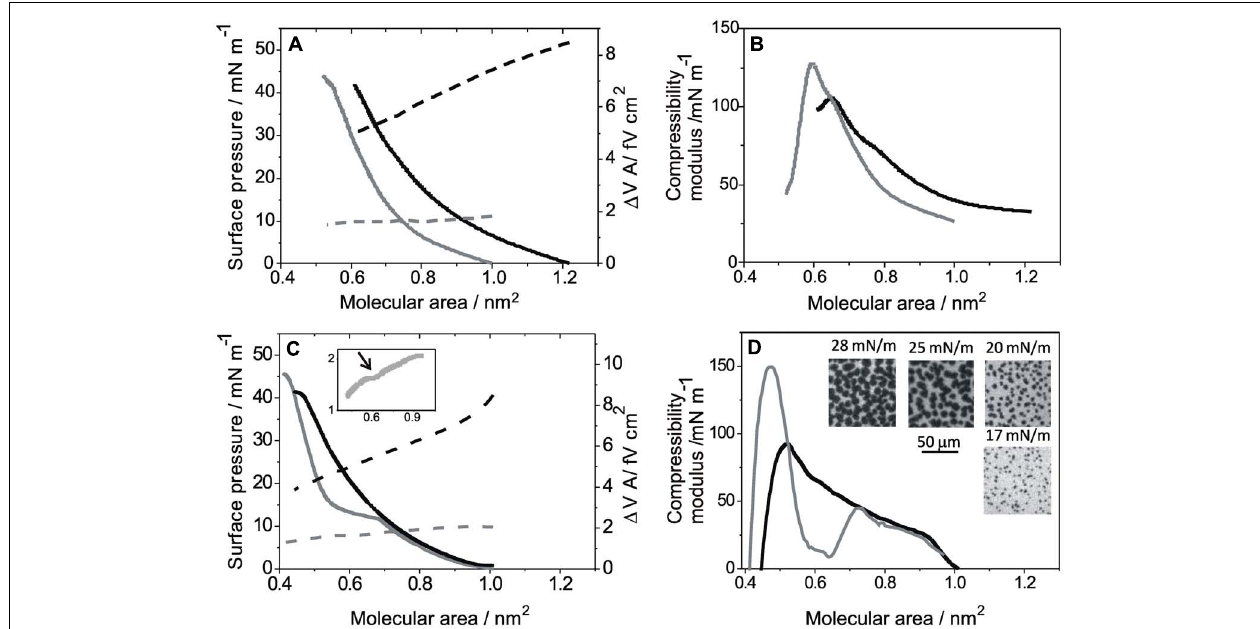
FIGURE 1 | Compression isotherms for monolayers of diacylglycerol pyrophosphate (DGPP) and palmitoyl-2-oleoyl- sn -glycerol 3 phosphate (POPA) on subphases at pH 5: (A) Lateral pressure (solid lines, left scale) and (cid:4) V · A (dashed line, right scale) as a function of the mean molecular area for DGPP monolayers. (B) Compressibility modulus for the isotherms shown in A . (C) Lateral pressure (solid lines, left scale) and (cid:4) V · A (dashed line, right scale) as a function of the mean molecular area for POPA monolayers. Inset: